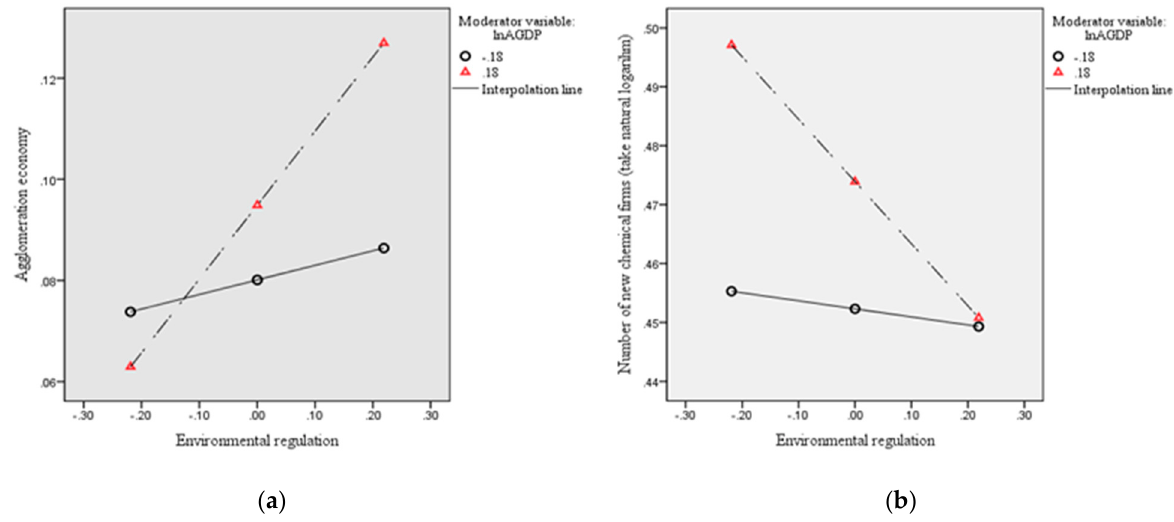
Figure 3. Moderating role of the economic development level (simple slope analysis). ( a ) Simple slope analysis of regions with high levels of economic development; ( b ) Simple slope analysis of regions with low levels of economic development.